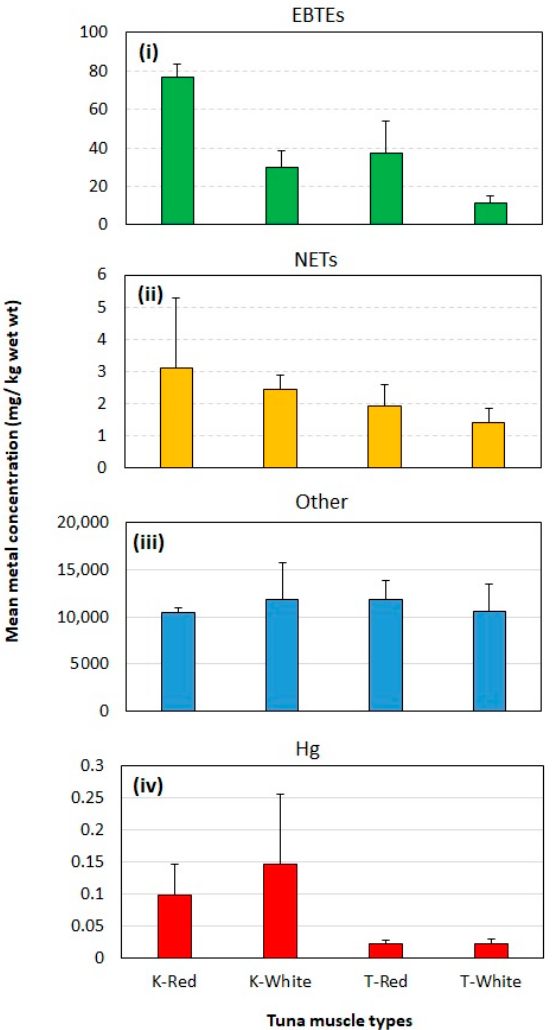
Figure 4. Mean concentration + standard deviation (SD) (mg/kg ww) of the three element groups (EBTEs: essential but toxic in excess quantities ( i ), NETs: non-essential toxic ( ii ), and Other ( iii )), and mercury ( iv ) in the white and red muscles of yellowfin tuna (T: T. albacares ), and skipjack tuna (K: K. pelamis ) collected from Sri Lanka.